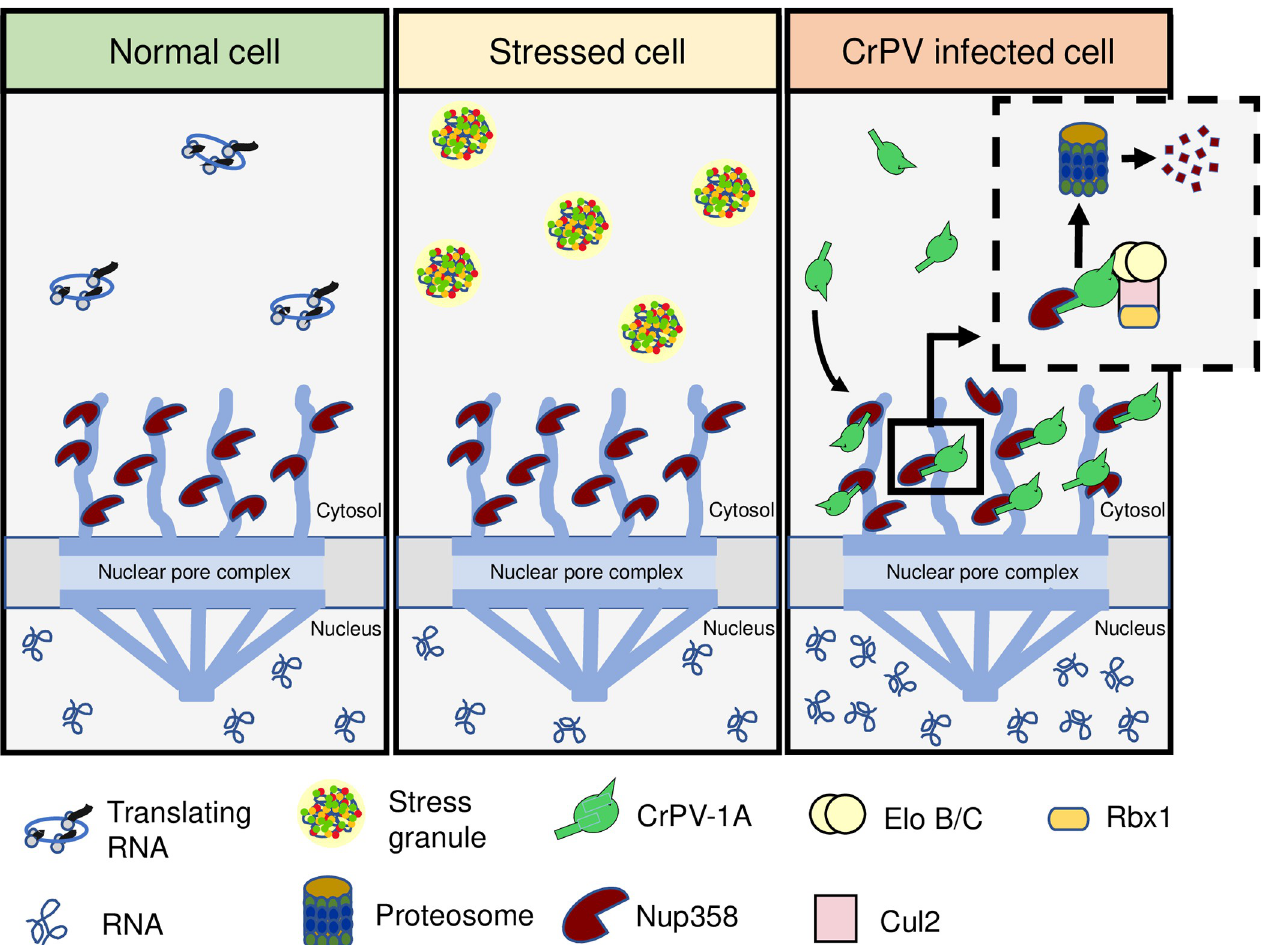
Fig 10. Model of stress granule inhibition by CrPV-1A. During CrPV infection, CrPV-1A localizes to the nuclear membrane in an R146-dependent manner and recruits Cul2-Rbx1-EloBC complex to ubiquitinate Nup358 leading to its degradation. The degradation of Nup358 results in a block in mRNA export, resulting in the enrichment of poly (A)+ mRNAs in the nucleus, and together inhibits stress granule formation which, facilitates virus infection.